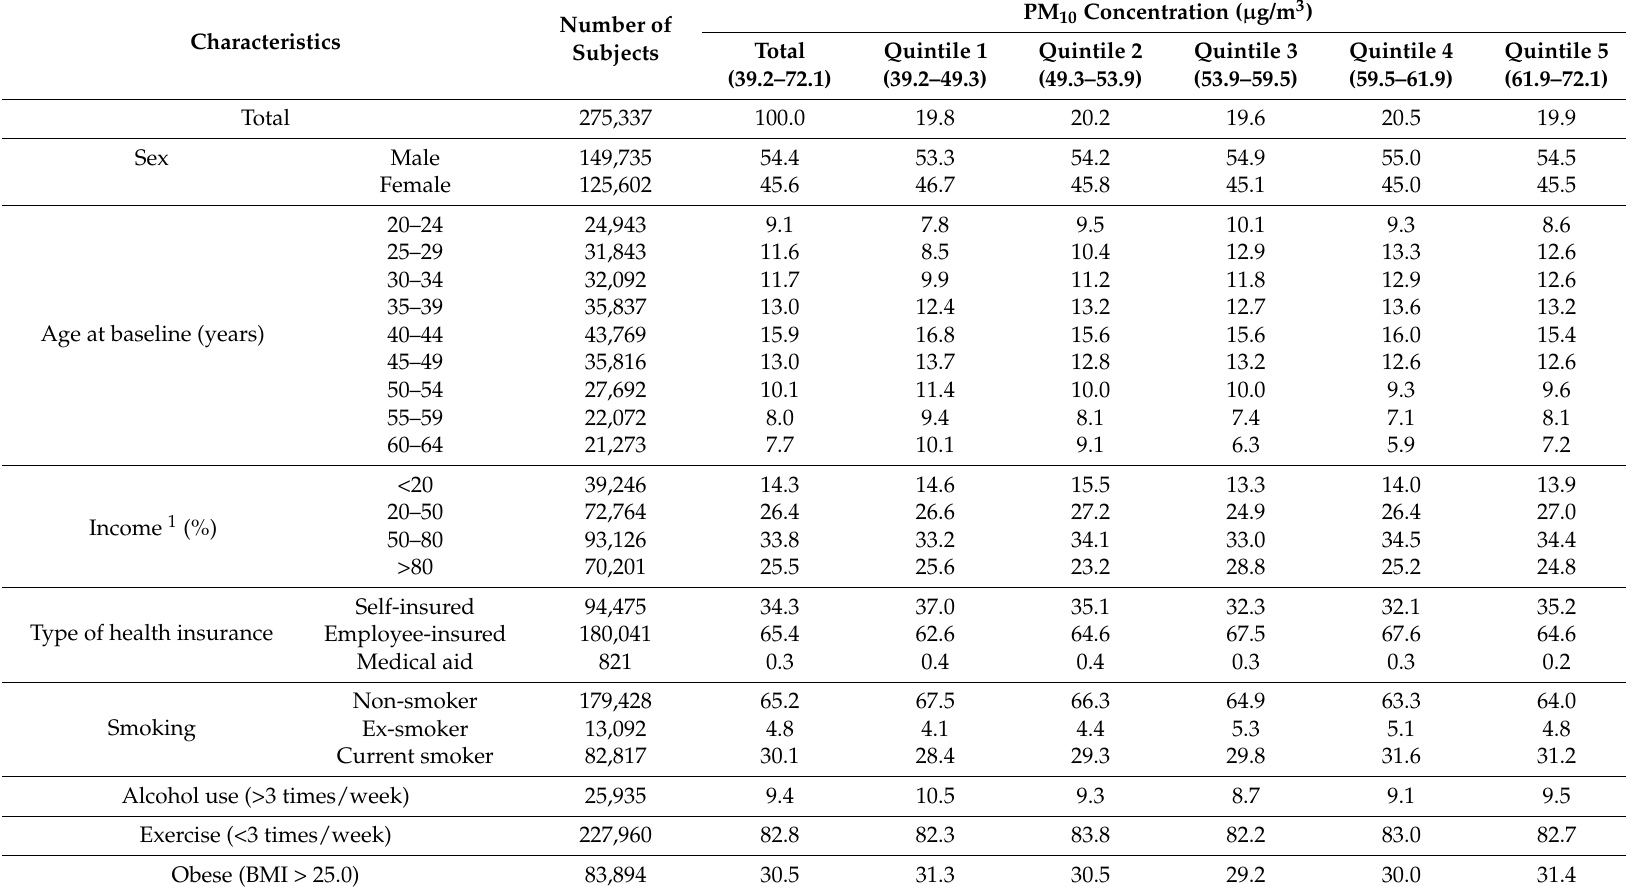
Table 1. Summaries of demographic characteristics (%) of 275,337 National Health Insurance Service- National Sample Cohort (NHIS-NSC) subjects for 2002–2013 across quintiles of their long-term PM 10 concentrations defined as 5-year averages calculated using annual average PM 10 concentrations at residential addresses for 2002–2006 in South